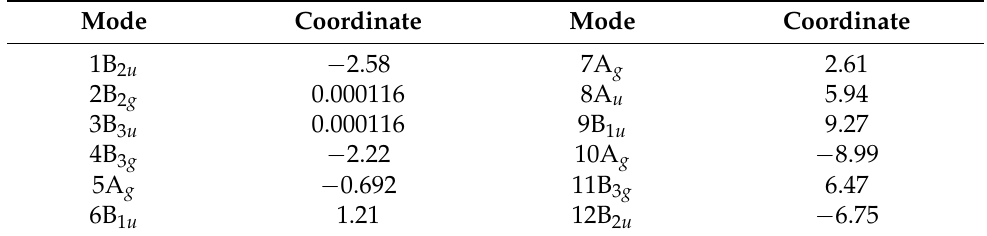
Figure 8. Sampled normal mode coordinates of ethene plotted as a function of the diffusion coor- dinates resulting from 12D dynamics. ( a ) 8A u normal mode coordinates as a function of diffusion coordinate θ 2 on the ground electronic state. ( b ) 8A u normal mode coordinates as a function of diffusion coordinate θ 2 on the first excited electronic state. ( c ) 7A g normal mode coordinates as a function of diffusion coordinate θ 3 on the first excited electronic state. In all cases data points are coloured according to the sample time; 20 gridpoints were sampled every 10fs during the dynamics, the first sampling on the ground state being after 10fs. Table 6. Dimensionless mass-frequency scale normal mode coordinates of the twisted-pyramidalised conical intersection. Mode frequencies given in Table